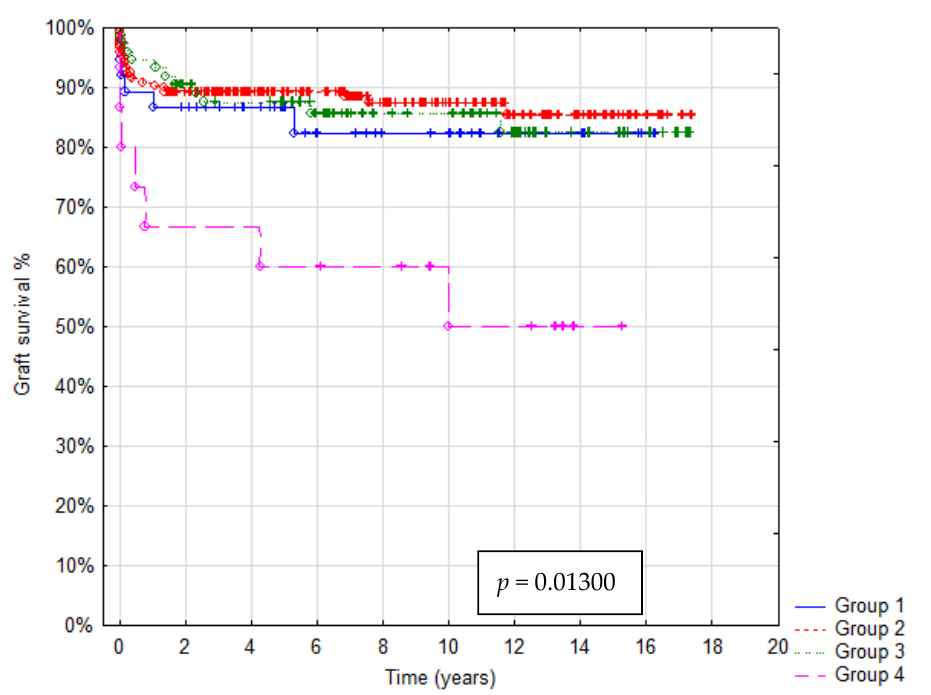
Figure 3. Kaplan–Meier graft survival curve.